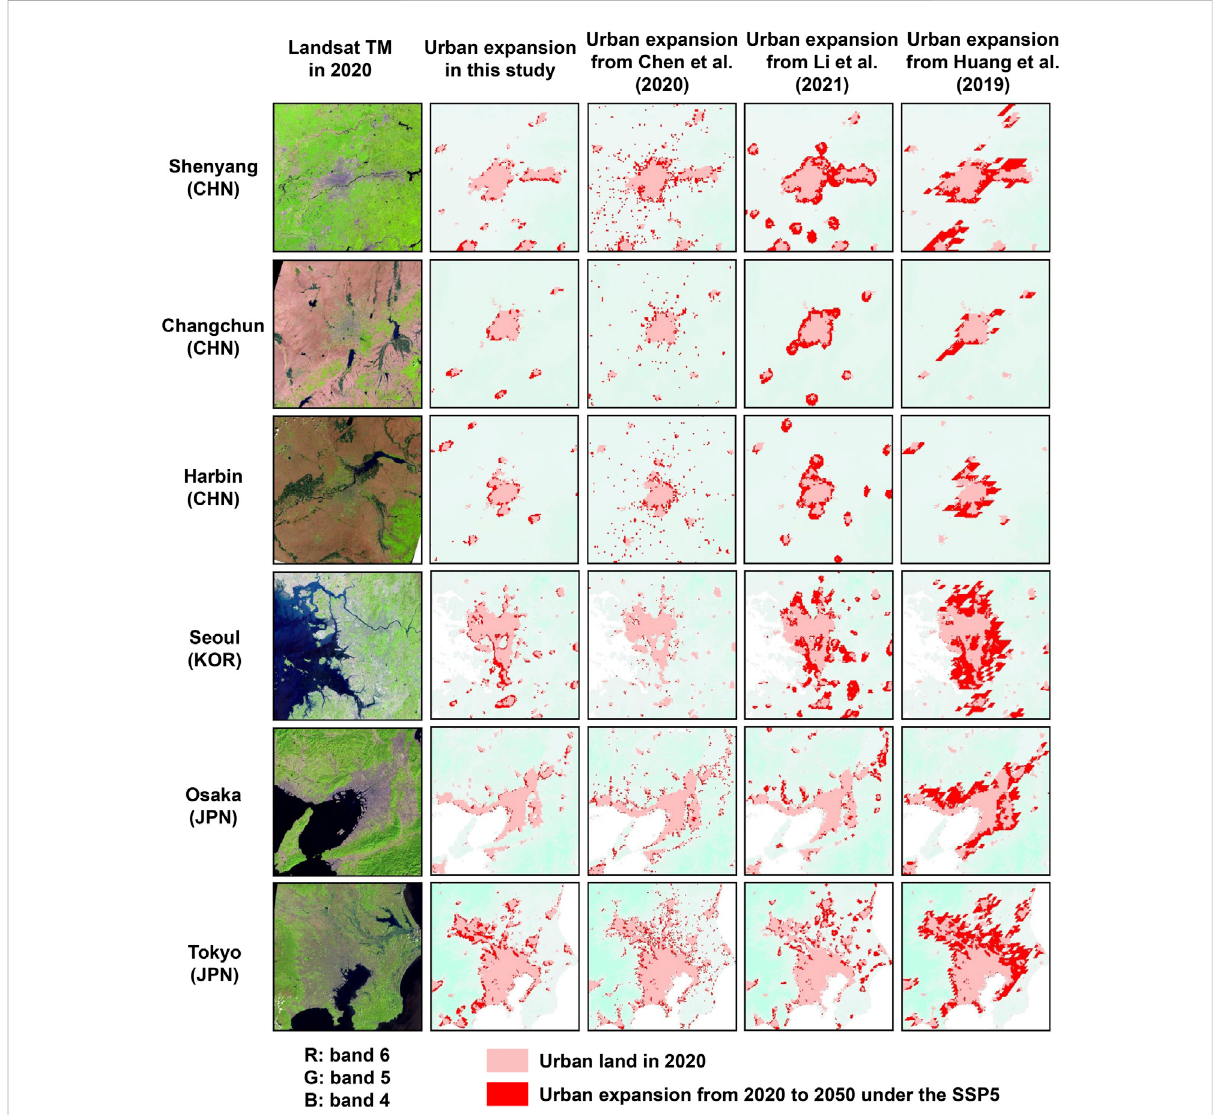
FIGURE 6 Comparison of urban expansion from 2020 to 2050 from this study and the other data issued by Huang et al. (2019), Chen et al. (2020), and Li et al. (2021).